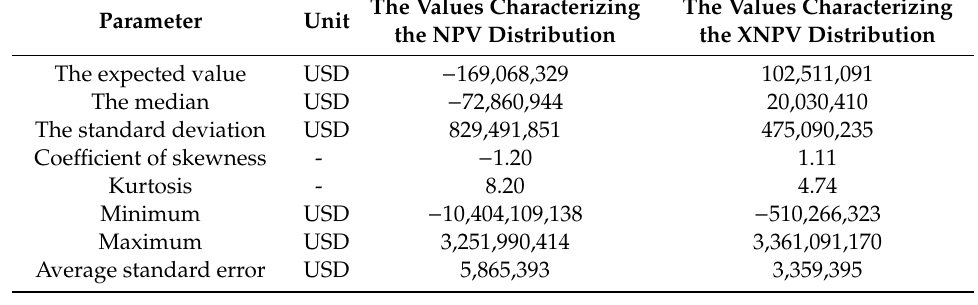
Table 3. The distribution parameters of the projected variables of NPV and XNPV.